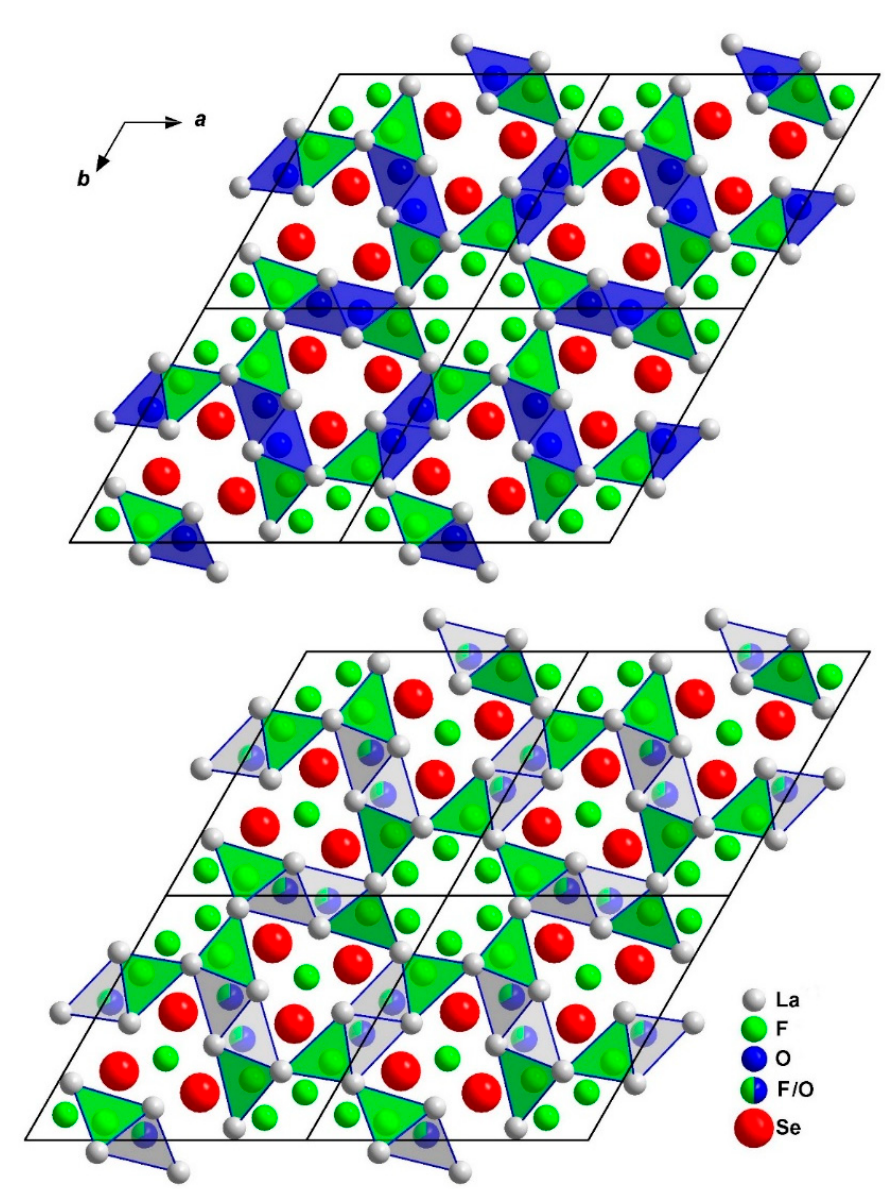
Figure 3. Comparison of the crystal structures of B-type La 2 OF 2 Se (top) and La 6 O 2 F 8 Se 3 (bottom) as viewed along their c- axes.